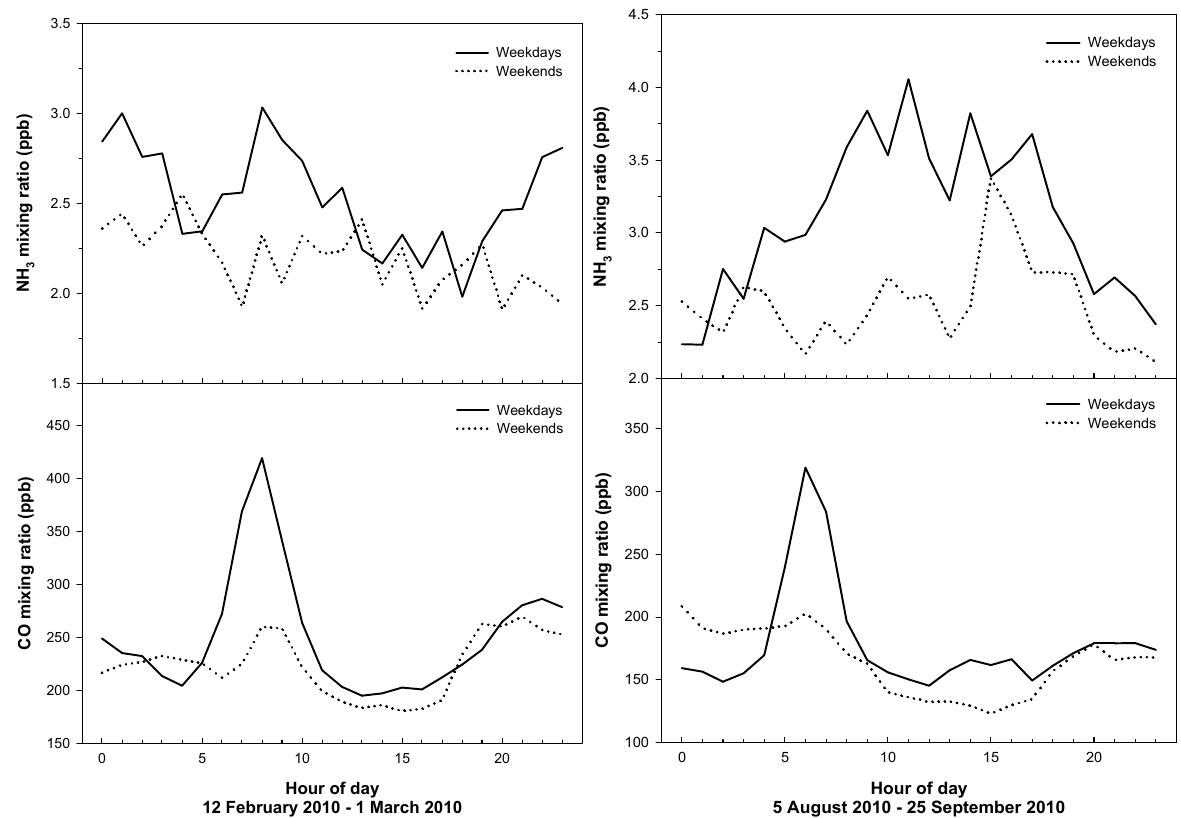
Fig. 10. Comparisons of hourly-averaged NH 3 and CO mixing ratios between weekdays and weekends during the two sampling periods.